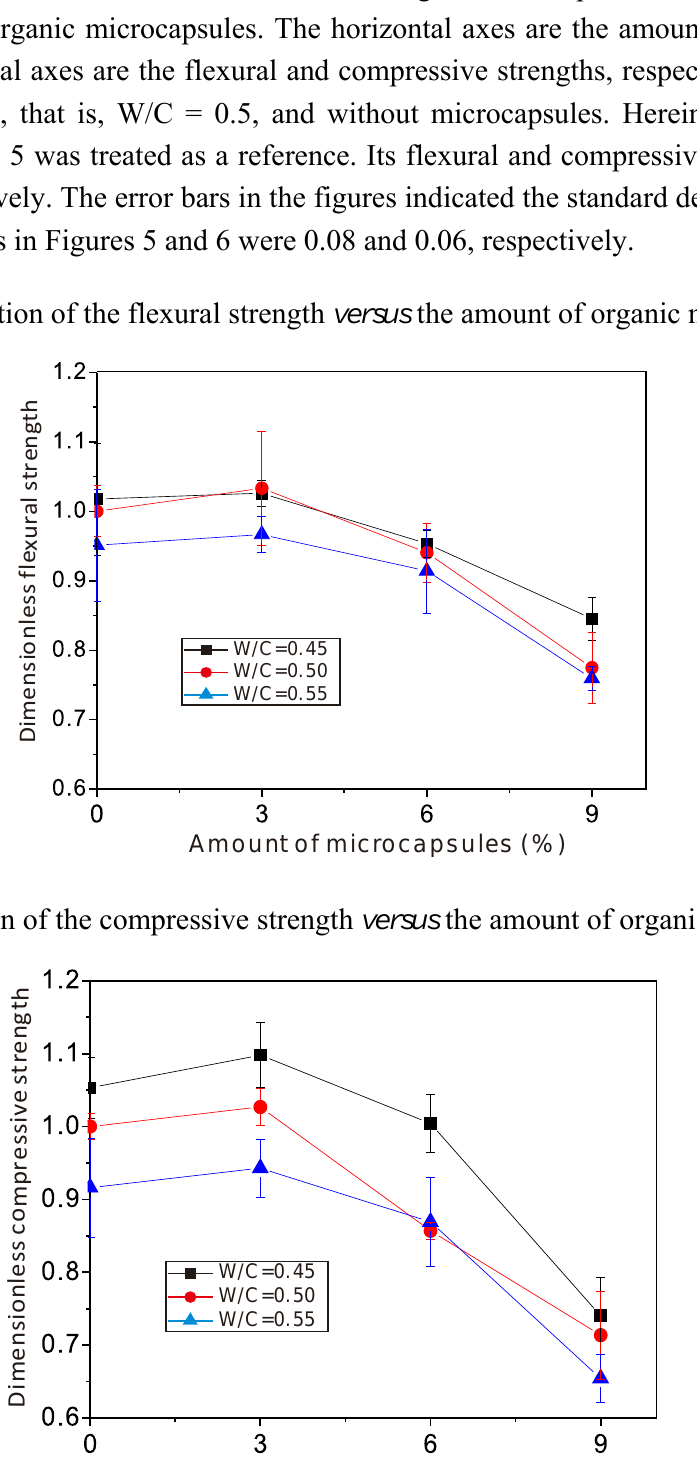
Amount of microcapsules